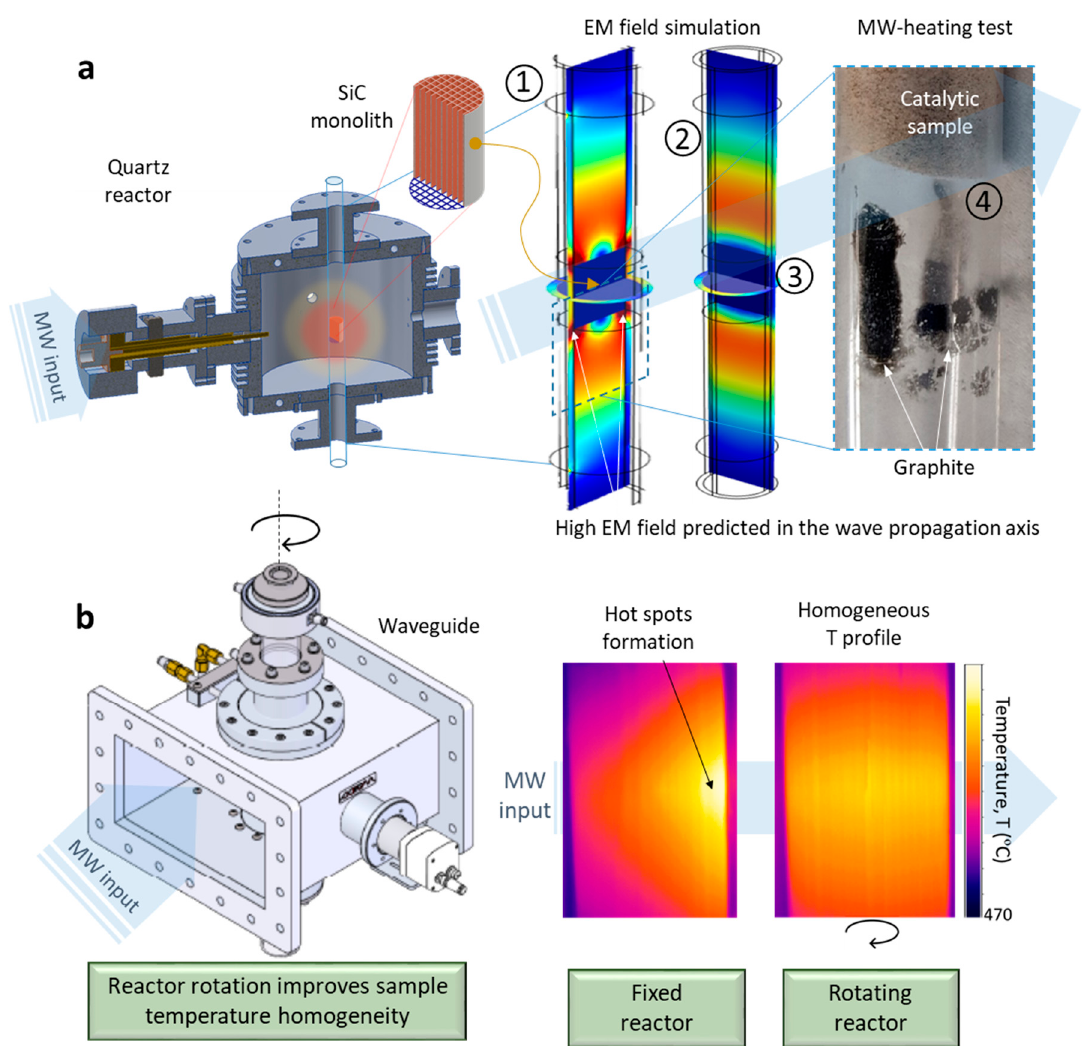
Figure 4. ( a ) Scheme of the lab-scale cylindrical cavity; simulated longitudinal and transverse EM field distribution maps at the inner reactor region; experimental coke deposition below the catalytic sample under MW-assisted MNOC operation; ( b ) scheme of the rectangular cavity with detail of reactor rotation; temperature distribution map along the scaled monolith wall for standing and rotating configurations.